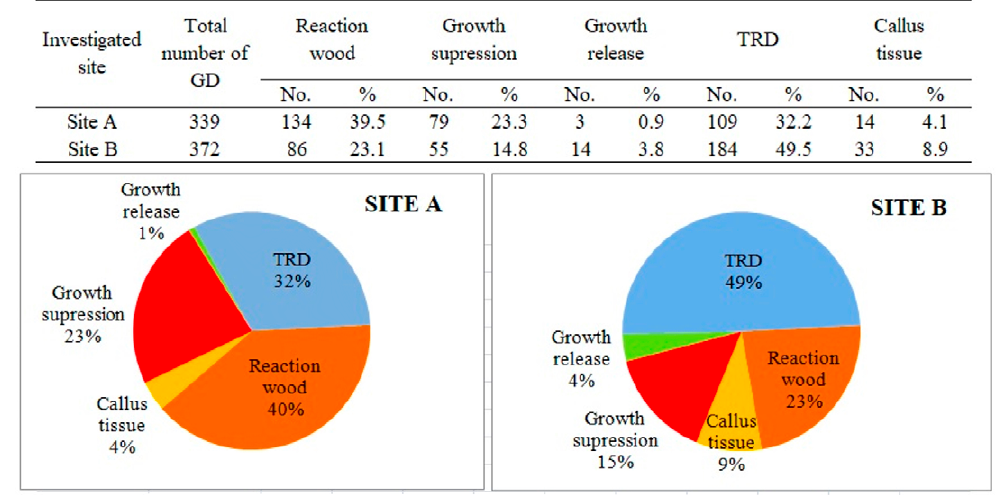
Figure 5. Distribution of GD types at the two investigated